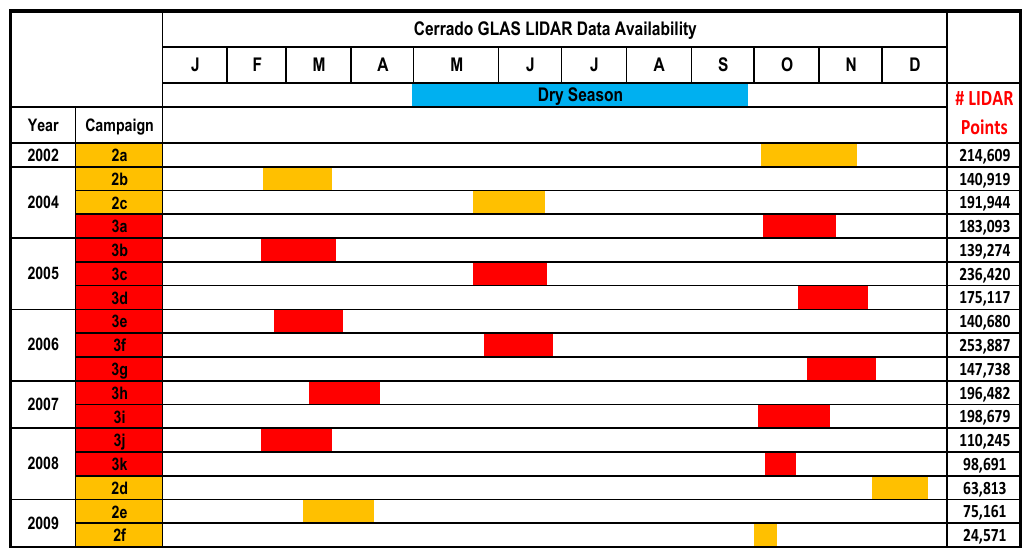
Table 1. Time and duration of each GLAS LIDAR campaign and respective amount of data acquired over the Cerrado biome.